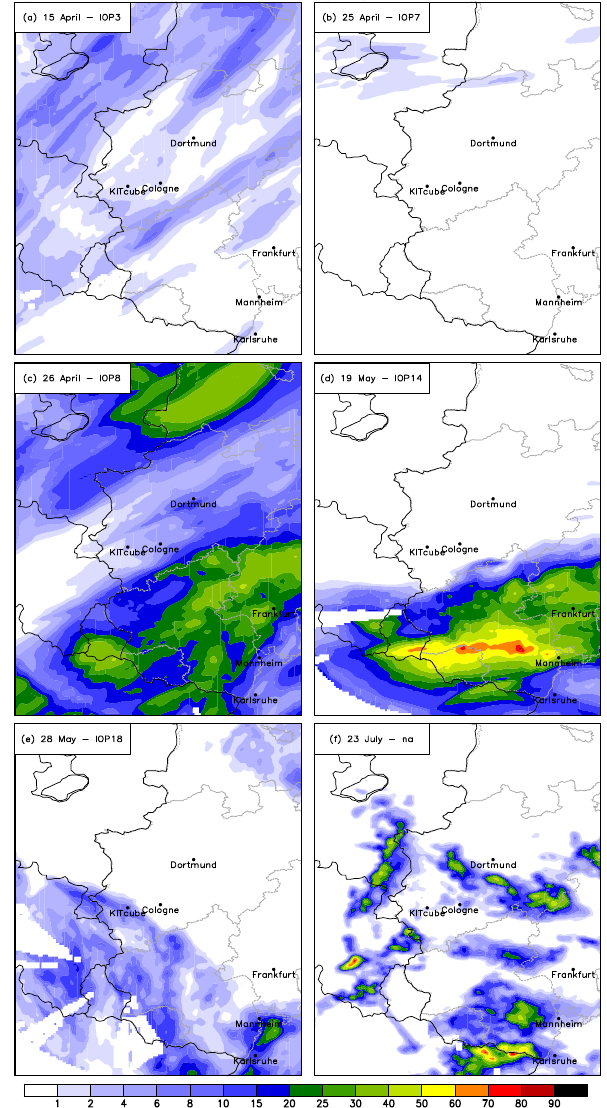
Figure 3. Precipitation amount over 24h, derived from radar mea- surements (interpolated to the operational COSMO-DE model grid with 2.8km horizontal grid spacing) for the analyzed days. The area shown is the common investigation area already depicted in Fig. 1. Note that 24 April is not shown due to the lack of observed precipi- tation.